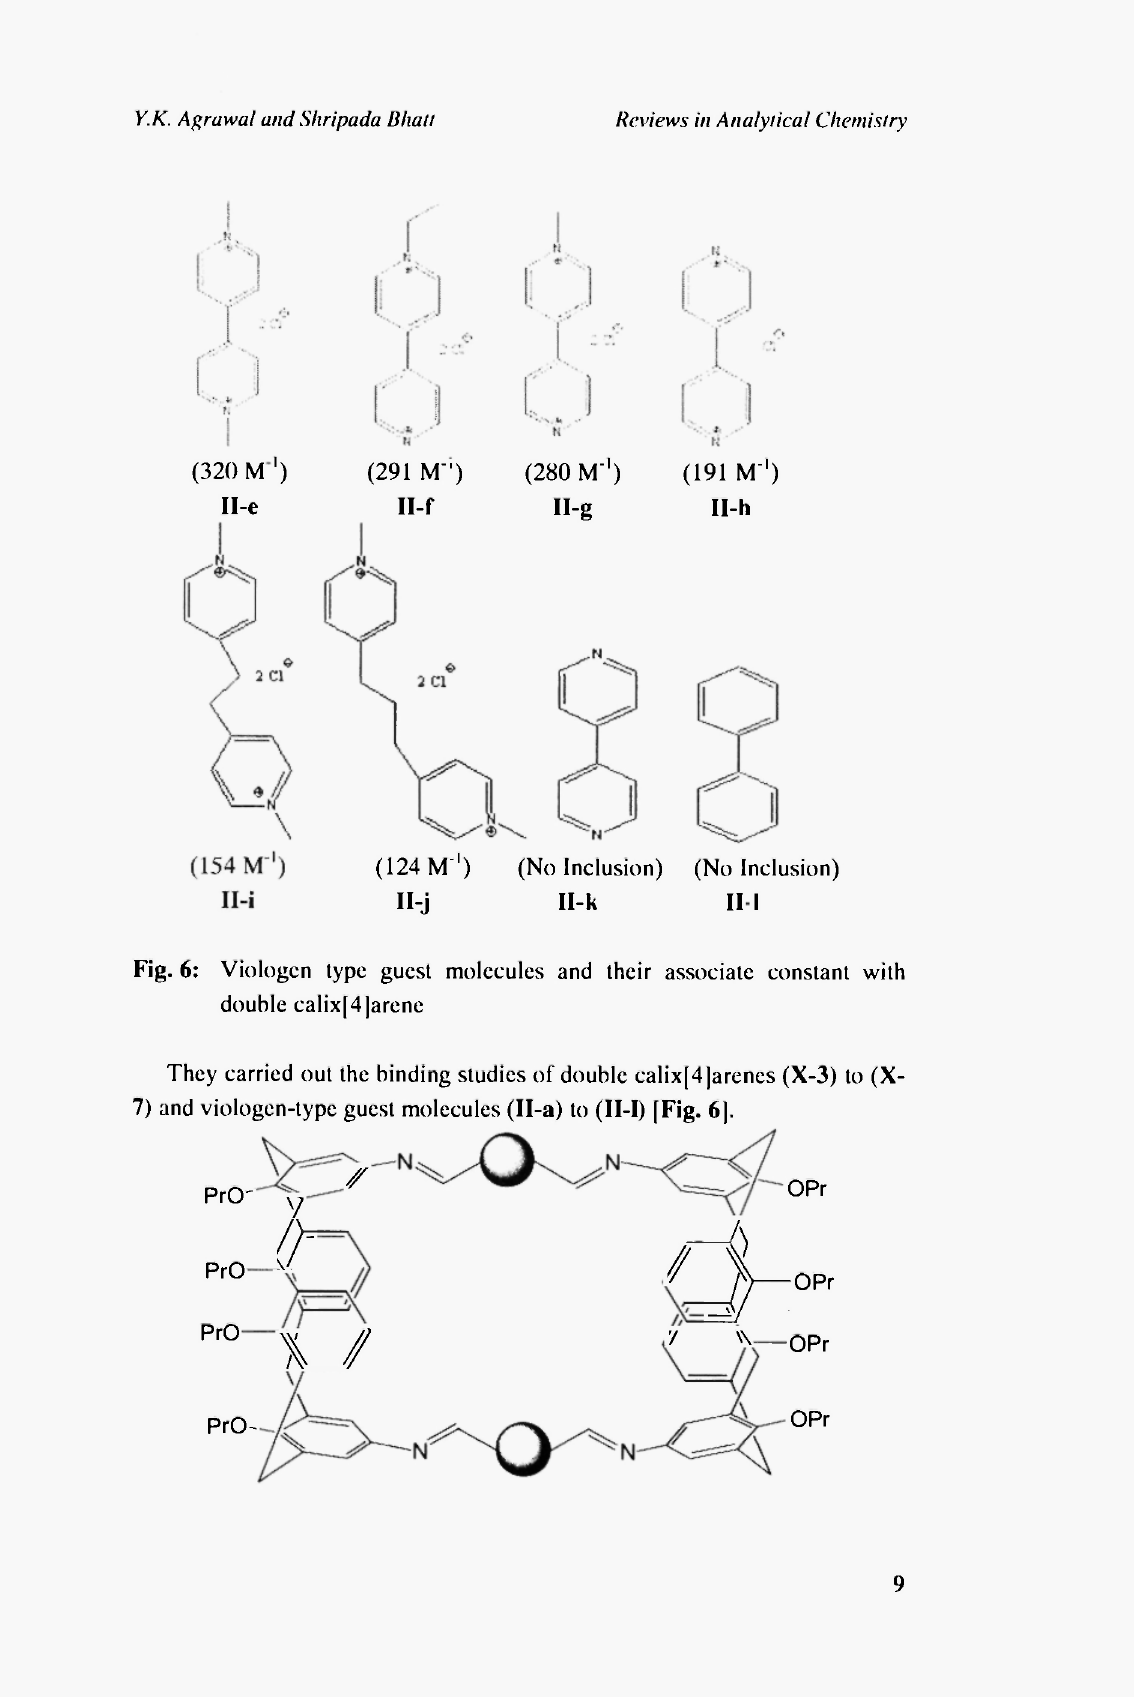
They carried out the binding studies of double calix[4]arenes (X-3) to (X- 7) and viologen-type guest molecules (Il-a) to (II-I) [Fig. 6].